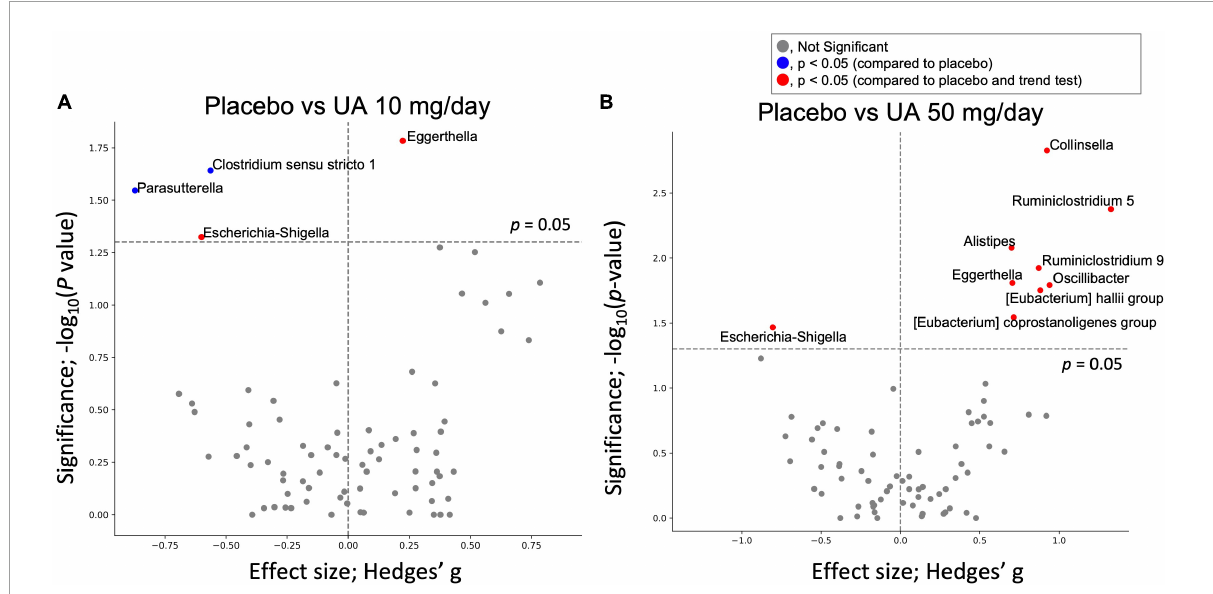
FIGURE3 Effect of UA on gut bacteria. Volcano plot of the effect of UA intake on gut bacteria; X-axis represents the Hedges’ g compared with the placebo group. Y-axis is the logarithm of the statistical test’s p -value (Wilcoxon signed-rank test). (A) Compares the placebo group with UA 10 mg/day group, and (B) compares the placebo group with UA 50 mg/day group. UA, urolithin A.